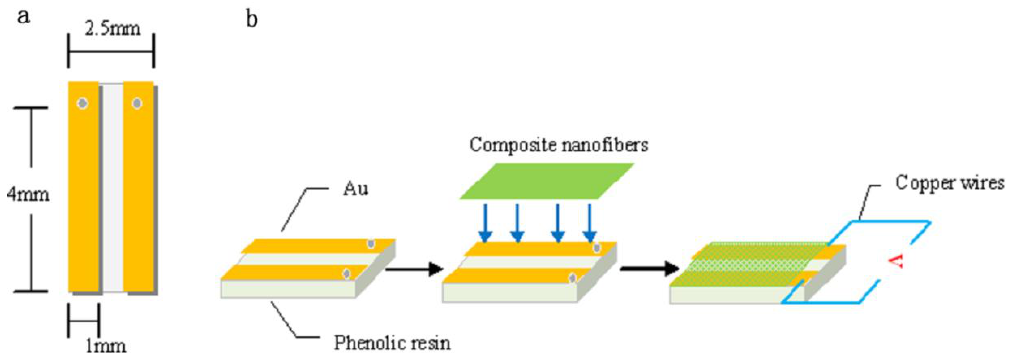
Figure 2. Schematic illustration of ( a ) home-made Au electrode and ( b ) sensing electrode.